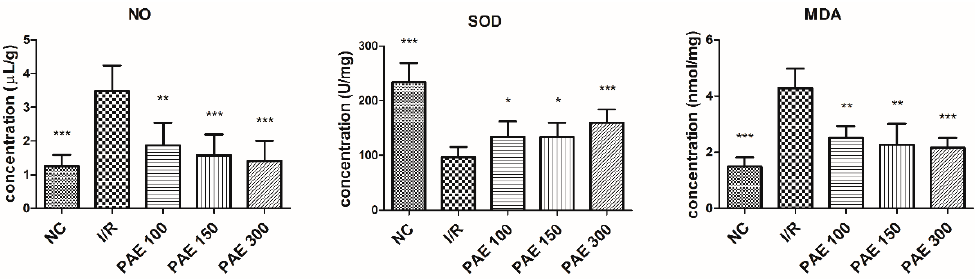
Figure 5. Effect of PAEs from Dongkui Myrica rubra on the nitric oxide (NO), malondialdehyde (MDA), and superoxide dismutase (SOD) contents in the brain tissue of mice with cerebral ischemia-reperfusion injury. The data are expressed as mean ± SD ( n = 10); * p < 0.05, ** p < 0.01, *** p < 0.001 vs. I/R group.